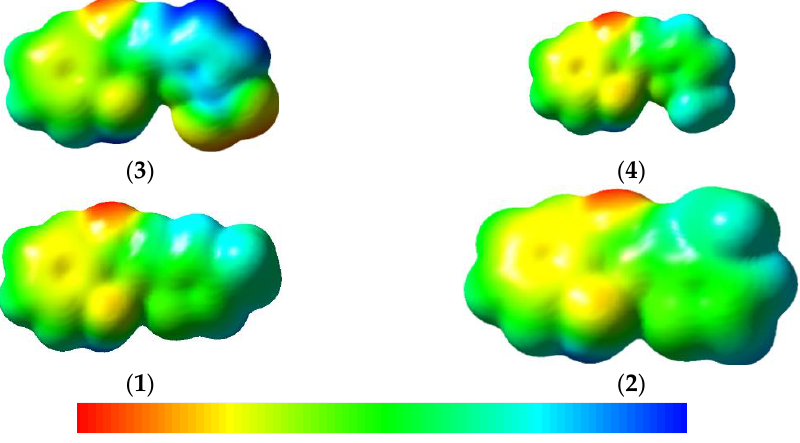
Figure 3. Molecular electrostatic potential views of Schiff base compounds.